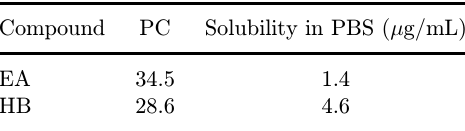
Table 2. The PC and solubility in PBS.